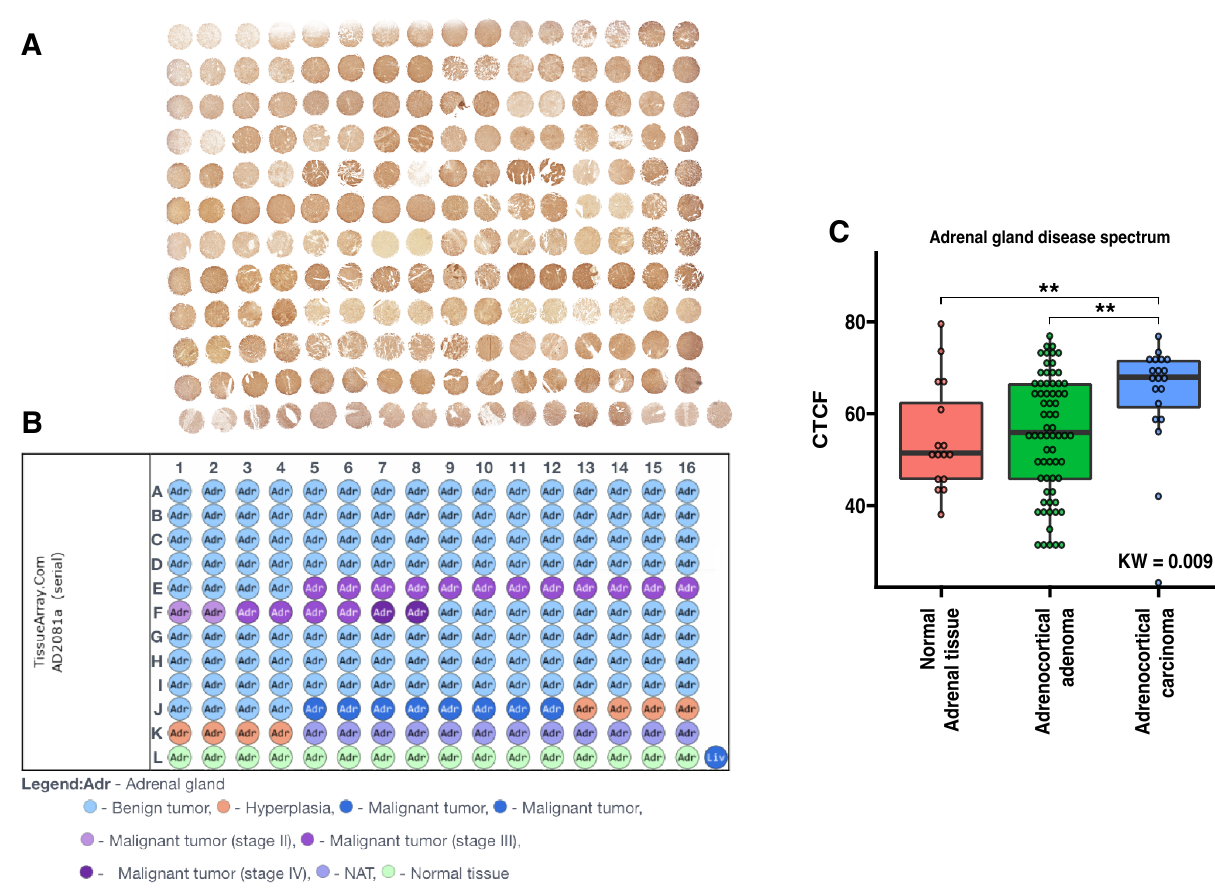
Figure 10. The expression of ZWILCH protein in human adrenal gland disease spectrum (adrenal cancer progression) tissue microarray (TMA) slide. The general profile of immunohistochemical staining presents localization of ZWILCH protein ( A ). TMA map shows the relevant types of adrenal cancer progression marked in an appropriate color ( B ). Densitometric analysis of ZWILCH gene expression in the tissue array side of the adrenal gland disease spectrum. The boxplot displays each group with its median and interquartile range (IQR) ( C ). Individual patient densitometric data were added to the corresponding boxplots and represented as dots. The Kruskal–Wallis (KW) test was used to compare groups, followed by the Dunn post hoc test. Differences between groups were marked with asterisks: ** for p < 0.01. Letter annotation was used to indicate statistically significant differences ( p < 0.05) between compared groups. Paired comparisons with post hoc Dunn p -values are also shown in the